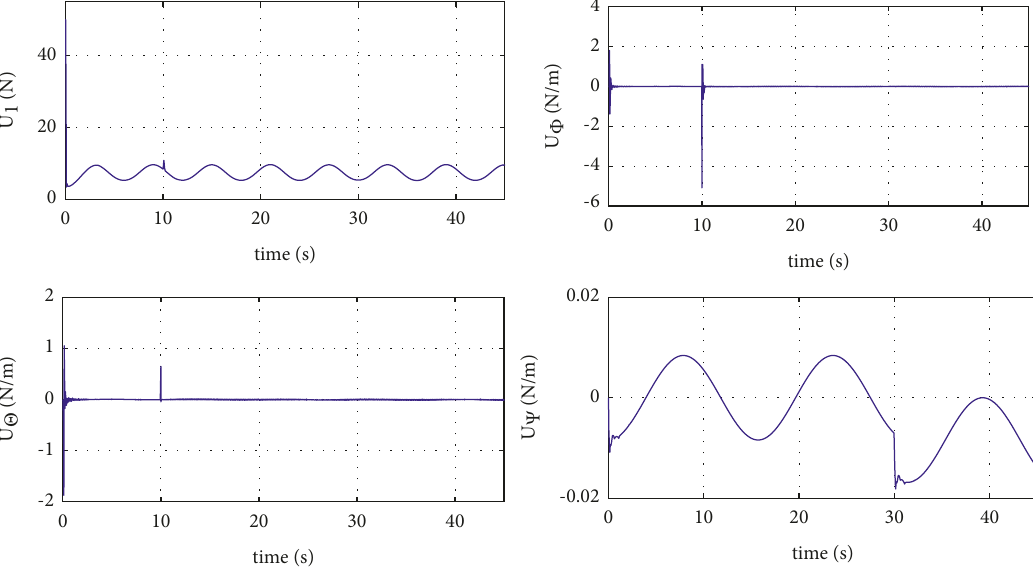
Figure 15: Control effort and